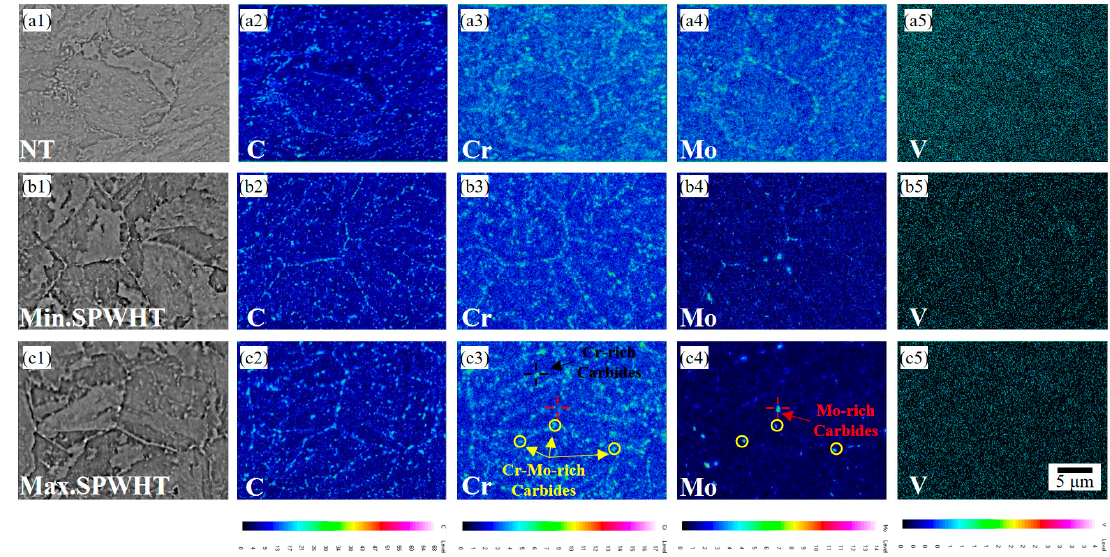
Figure 7. Distribution of C, Cr, Mo, and V in the 2.25Cr1Mo0.25V steel in the ( a1 – a5 ) NT, ( b1 – b5 ) Min.SPWHT, and ( c1 – c5 ) Max.SPWHT states by EPMA.